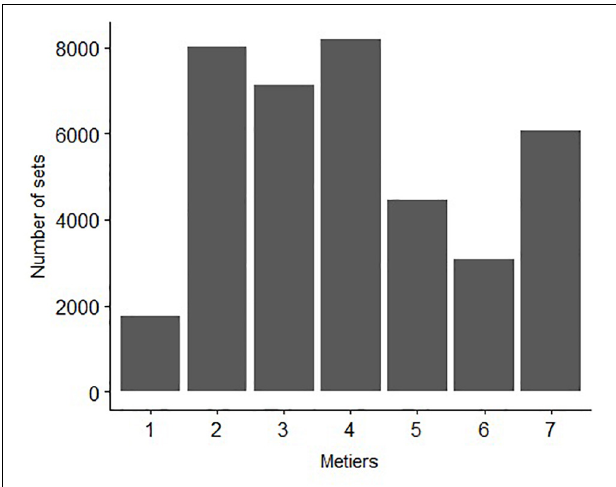
FIGURE 3 | Number of sets attributed to each métier in the Eastern Tuna and Billfish Fishery (ETBF) for the period